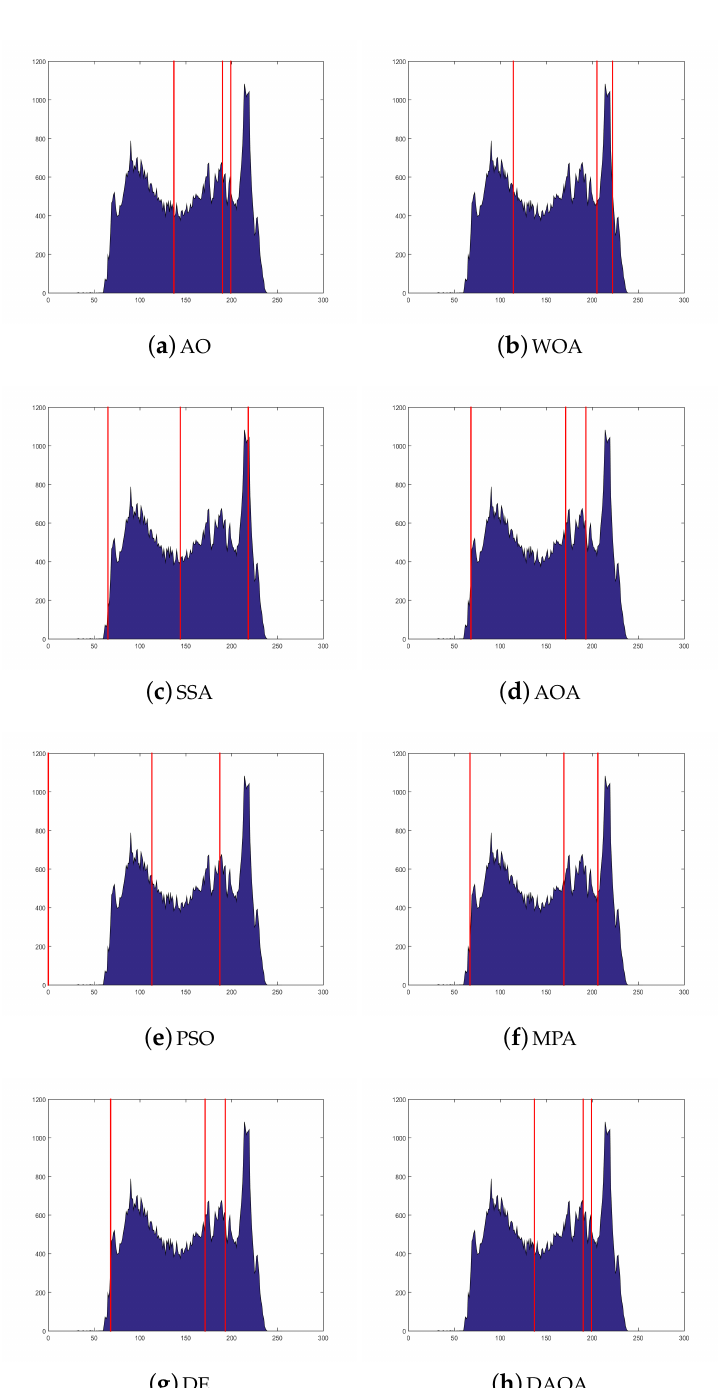
Figure 12. The histogram image (Test 8) by the comparative methods when the threshold value is